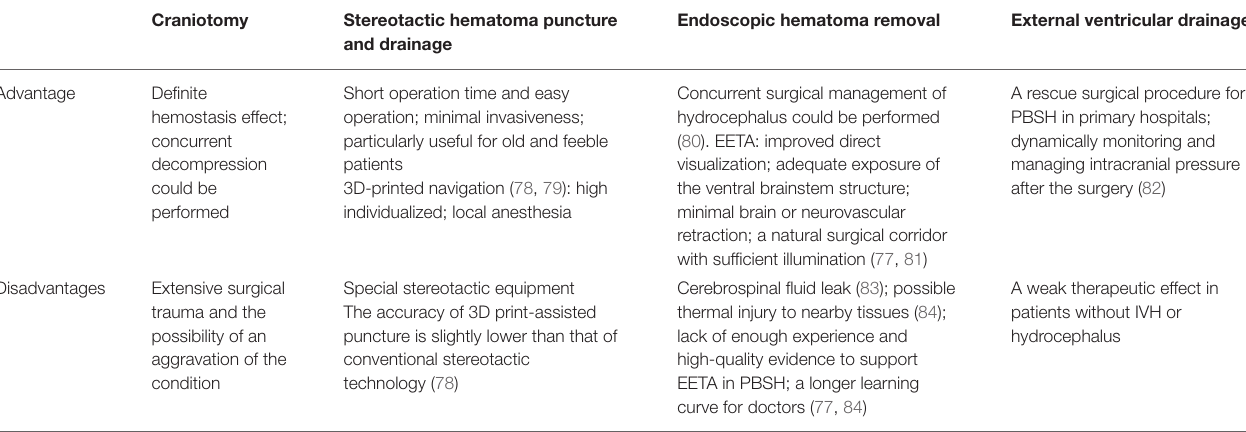
TABLE 4 | Comparison of advantages and disadvantages among the four surgical options of